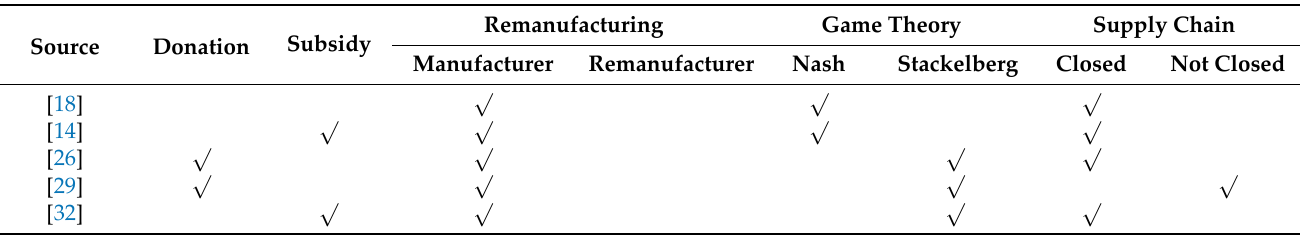
Table 1. Overview of recent